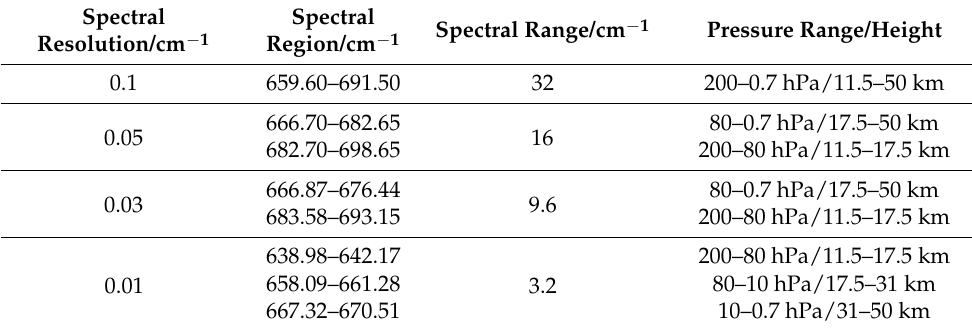
Table 3. The spectral region scheme of multiple narrow